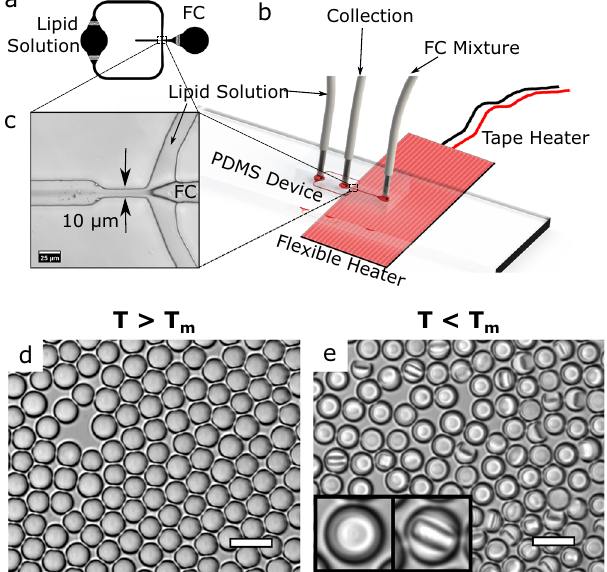
Fig. 1 Micro fl uidic fabrication of endoskeletal droplets. a Design of the Micro fl uidic Channel used to generate droplets. b Droplet generation schematic showing the PDMS device and different inlets and outlets. Zoomed in image of the fl ow-focusing junction is shown in c Scale bar, 25 μ m. d Endoskeletal droplets generated using this technique at a higher temperature ( T > T m ) are single-phase liquid droplets where the solid disks are all melted. When the droplets are cooled to a lower temperature ( T < T m ), the solid phase separates and forms the endoskeleton con fi ned by the droplet boundaries (shown in e ). The disks are randomly oriented with different orientations. Parallel orientation and perpendicular orientation of the disk are shown in the image inserts where the disks are seen as circle and rectangle respectively. Scale bar, 20 μ